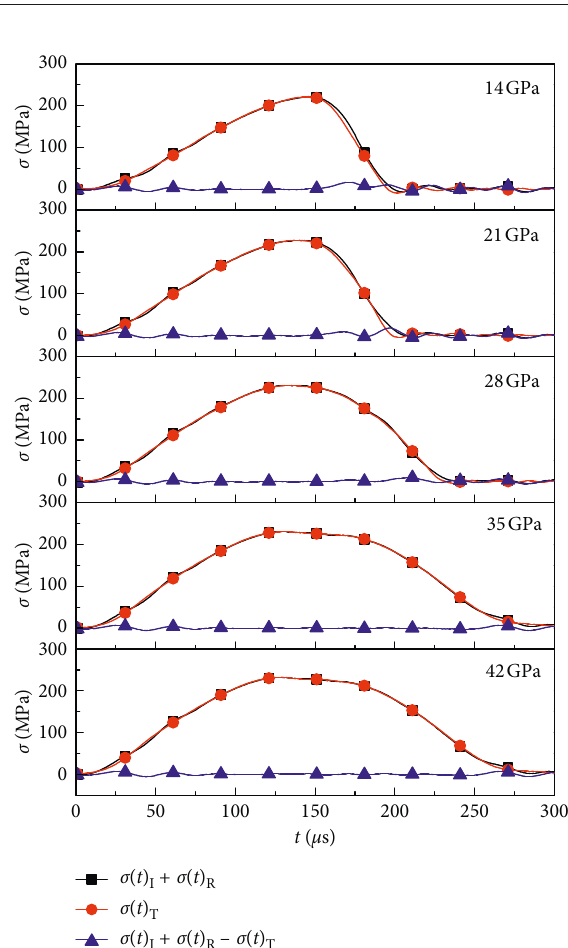
Figure 3: Stress-time histories on two ends of parallel end-face rocklike